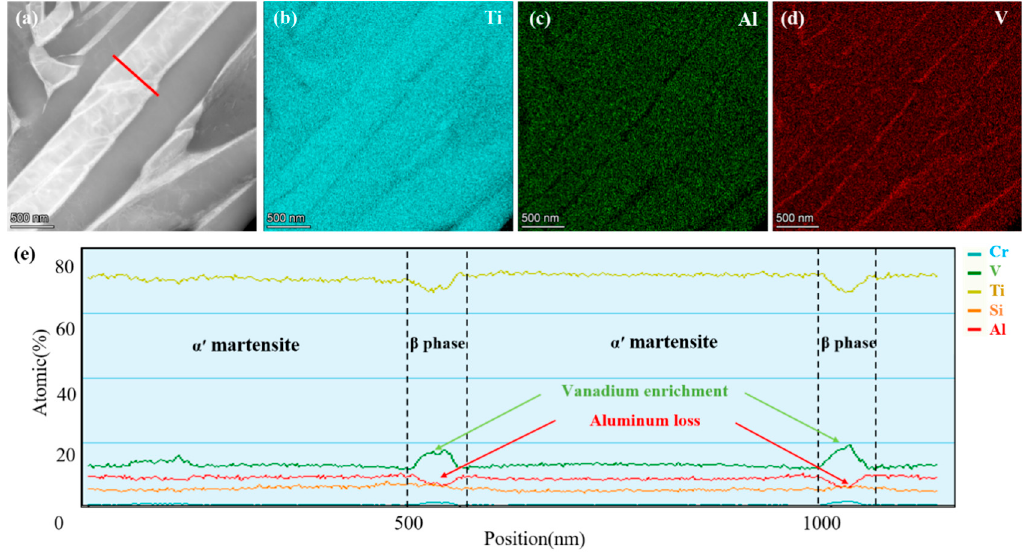
Figure 6. Local EDS mapping of the Ti64 WM: ( a ) HAADF; ( b ) Al; ( c ) Ti; ( d ) V; ( e ) EDS line scanning along the red line in Figure 6a.